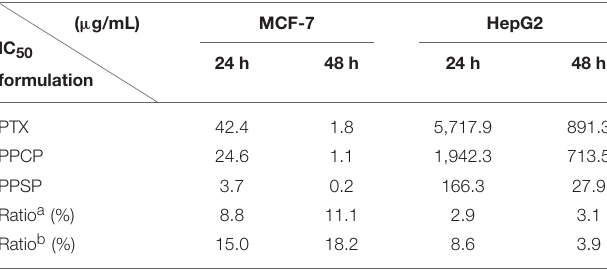
TABLE 2 | IC 50 values ( µ g/mL) of PPSP, PPCP, and free PTX against MCF-7 and HepG2 cells after treatment for 24 and 48h.